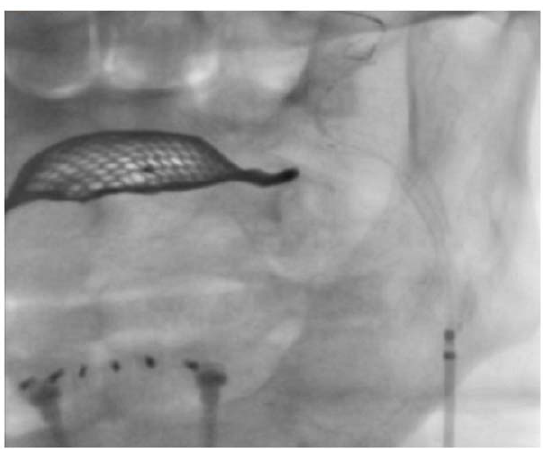
Figure 4. Angiogram after stenting the left internal carotid artery.